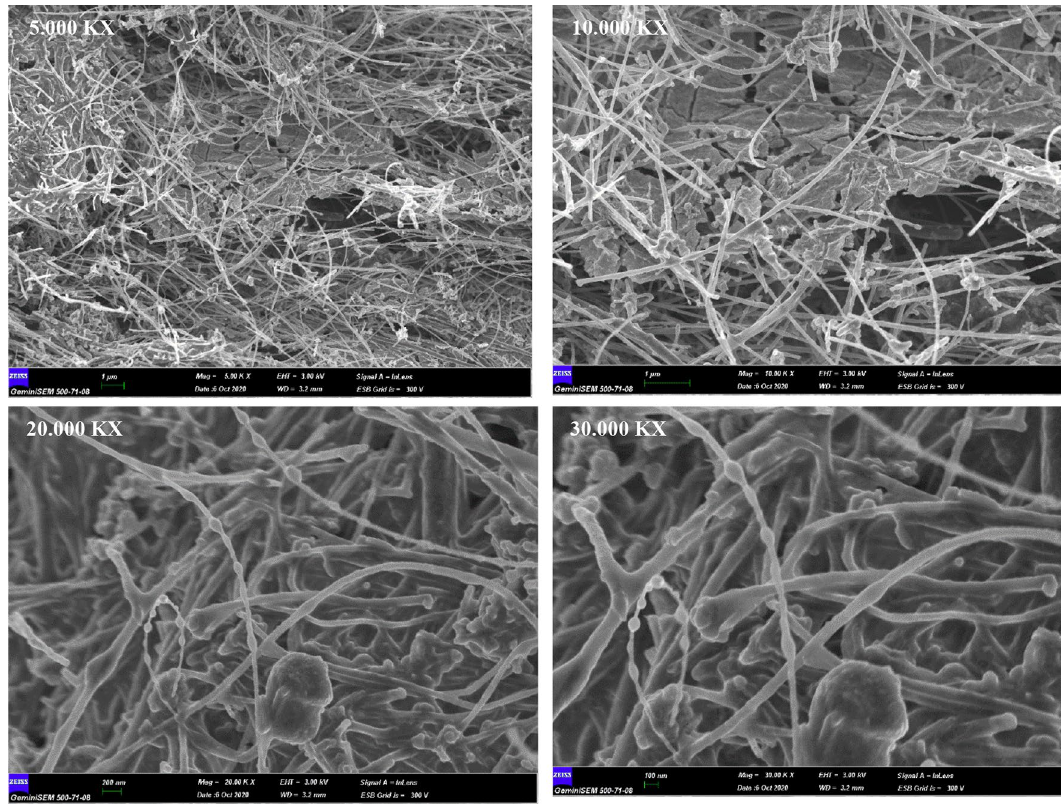
Figure 3. SEM images of MWCNT/Ruthenium hydroxide aerogel.